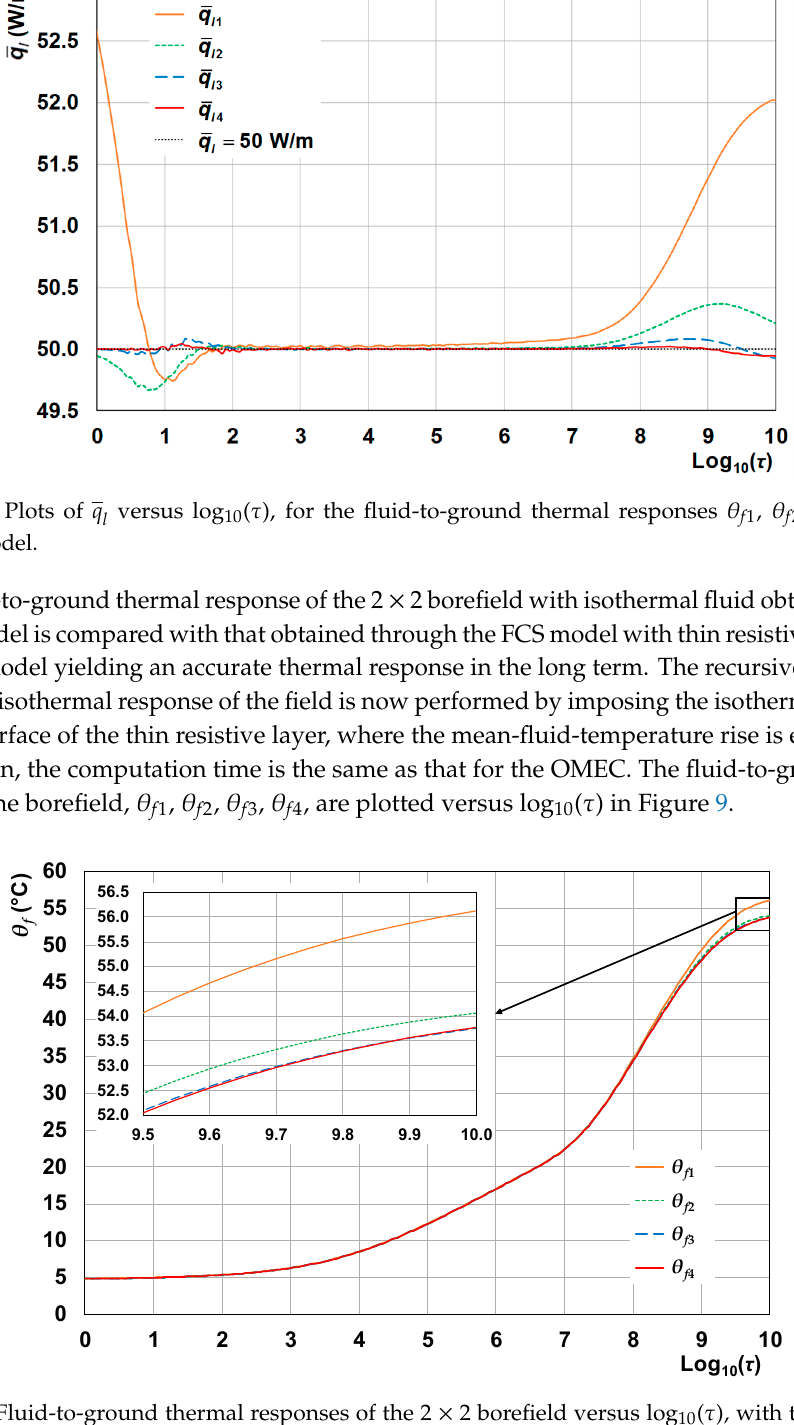
Figure 9. Fluid-to-ground thermal responses of the 2 × 2 borefield versus log 10 ( τ ), with the isoflux condition ( θ f 1 ) and with the isothermal conditions ( θ f 2 , θ f 3 , θ f 4 ), FCS model.